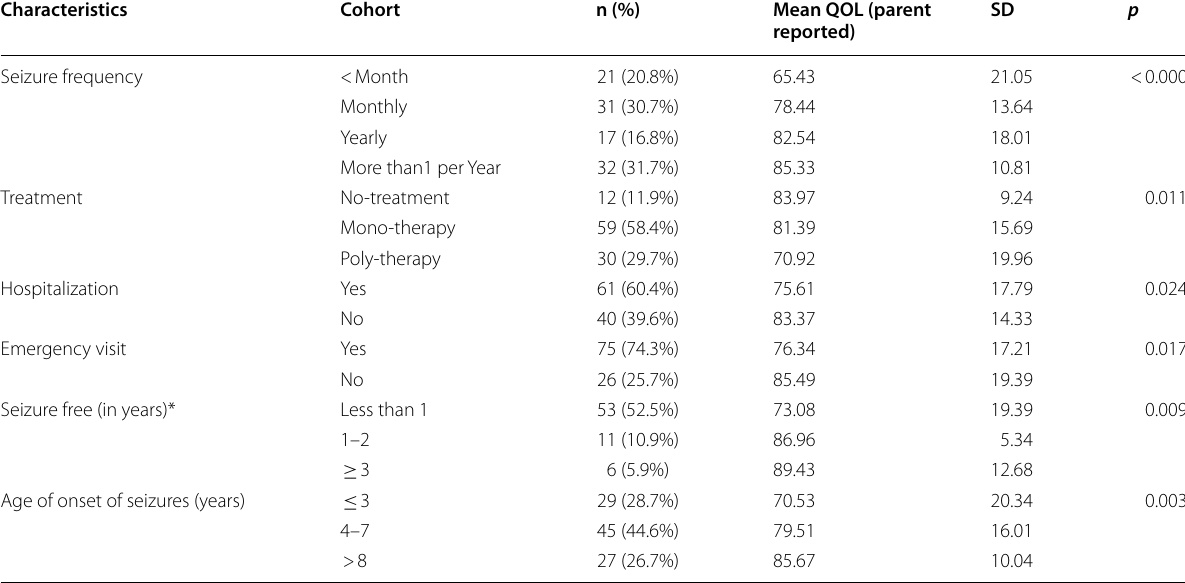
* Missing data was excluded from analysis